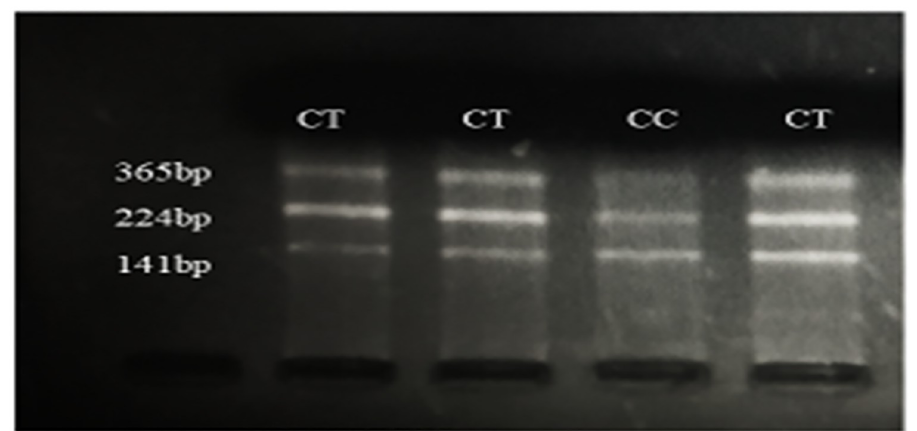
Fig 1. Identification of SNP rs17228602. Visualization of PCR products after digestion with restriction enzyme Psp5II (PpuMI) are shown on 2% ethidium bromide-stained agarose gel. Genotypes are shown above the lane and fragment size to the left of